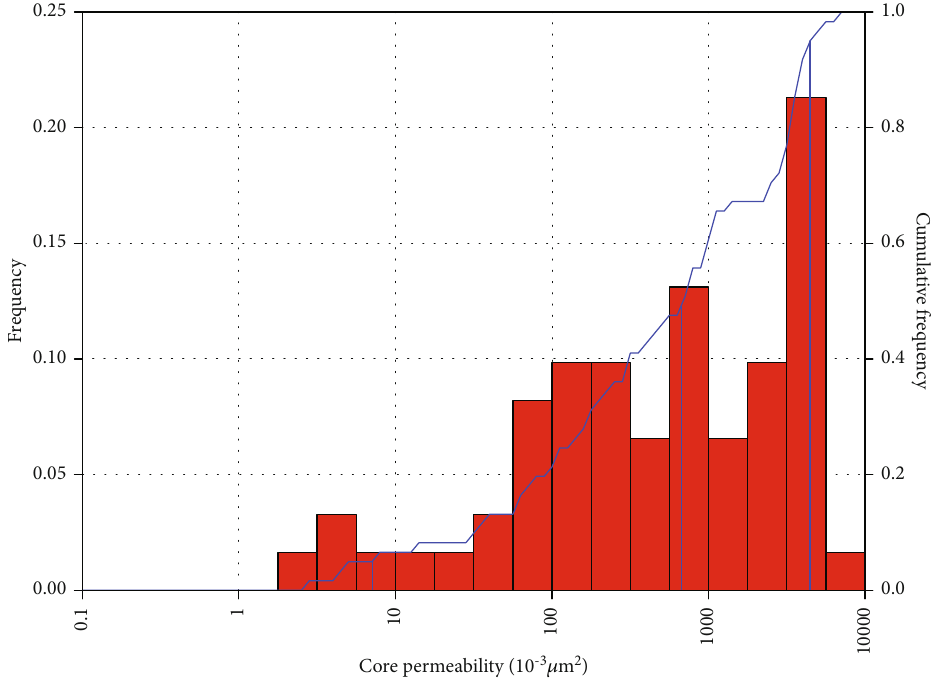
Figure 11: Histogram of permeability frequency distribution of Paleogene core analysis in Yingmai 7